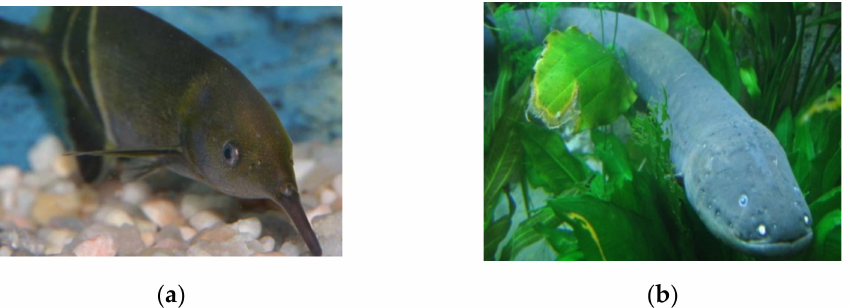
Figure 7. Fishes that can generate electrical energy in their bodies to search for food and navi- gate thorugh their habitat ( a ) Elephantnose fish (“ Gnathonemus petersii ”) [24] and ( b ) Electric eel (“ Electrophorus electricus ”) [25]. No changes were made to the original